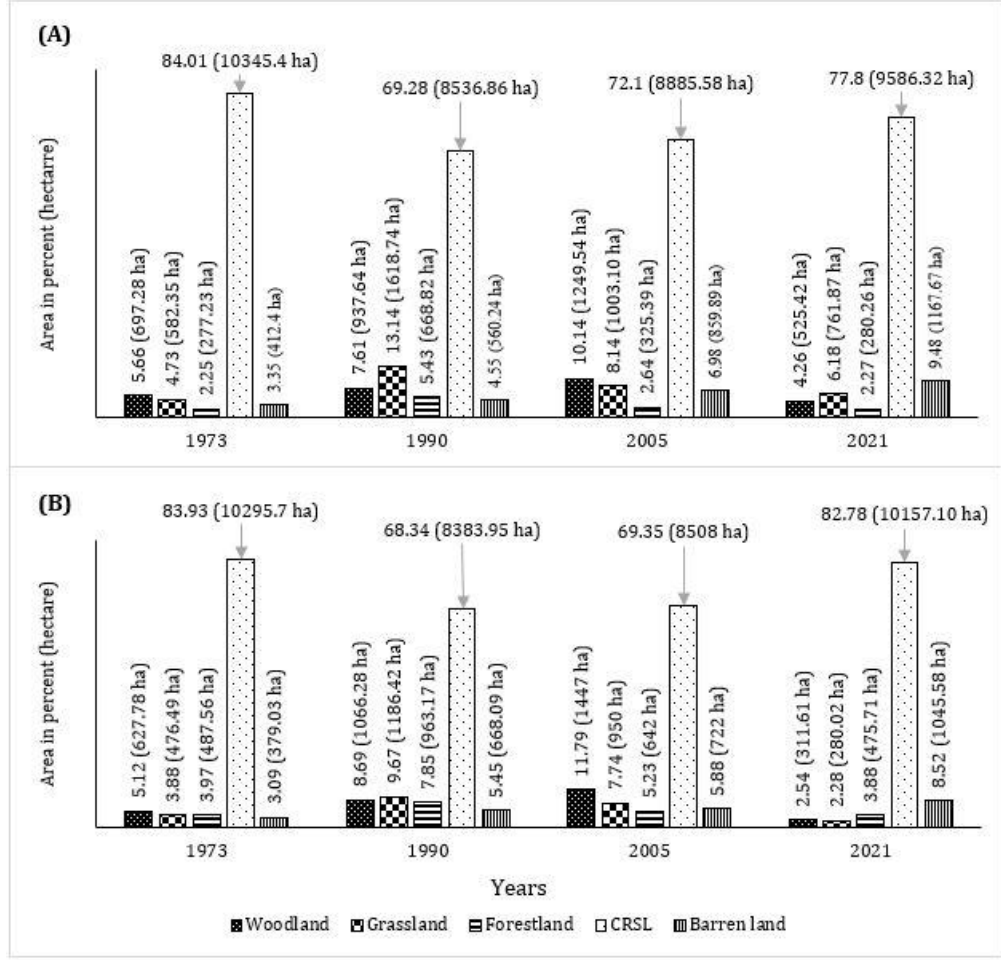
Fig. 4. Aerial coverage of LULC change in the Shankur Tareqo (A) and Mende Tufessa (B) micro-watersheds in 1973, 1990, 2005 and